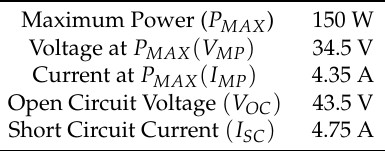
Table 1. Electrical characteristics of PV Module